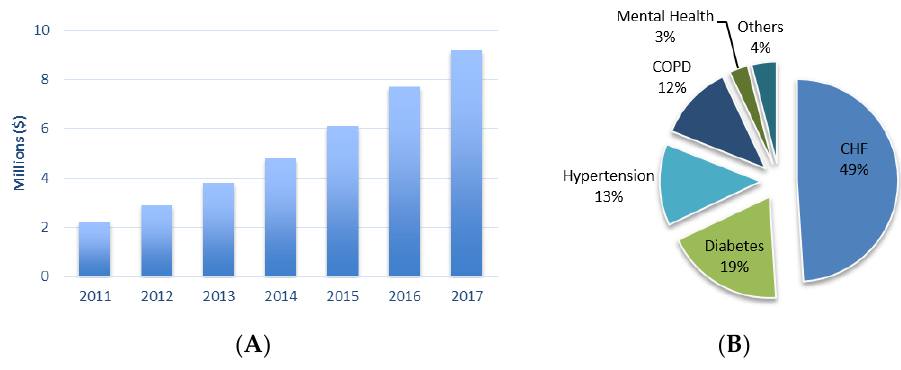
Figure 8. ( A ) Connected home medical monitoring devices (in millions) 2011 to 2017 [137]; ( B ) The world market for telehealth from 2014 divided in the main areas (CHF-congestive heart failures; COPD-chronic obstructive pulmonary disease) [138].